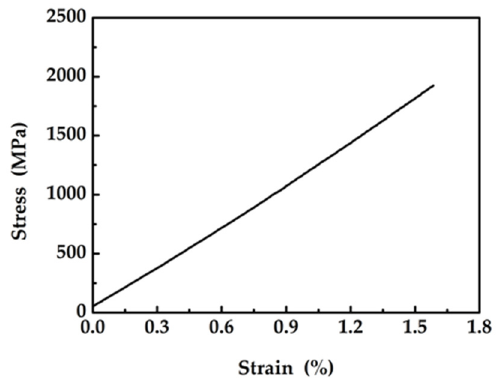
Figure 7. Stress-strain curve of composite core.